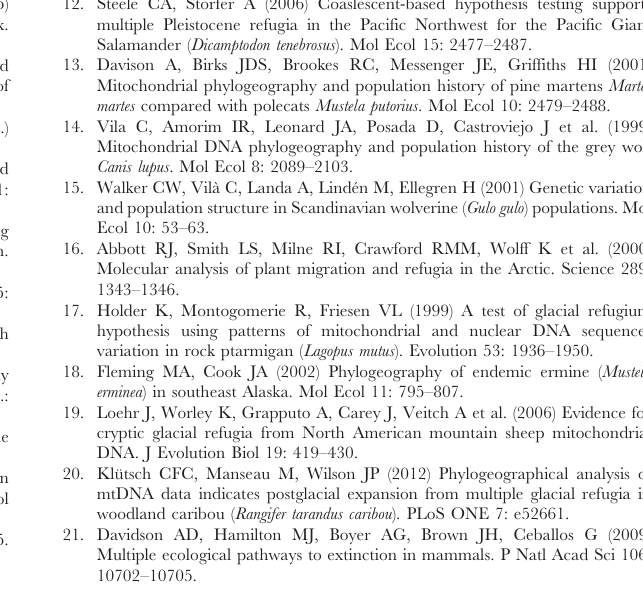
Table S2 Minimum and maximum limits and associat- ed coditions of parameters used in DIYABC analyses. Table S3 Control region haplotype labels discussed in this study and their corresponding designation(s) as identified in previous studies. Sequential numbering of each haplotype is reflective of when it was first published in the literature. Table S4 Variable nucleotide positions of identified haplotypes are denoted according to their location within the 318 bp portion of the D-loop mtDNA control region. Table S5 Percent frequencies of wolverine mtDNA control region haplotypes within and across